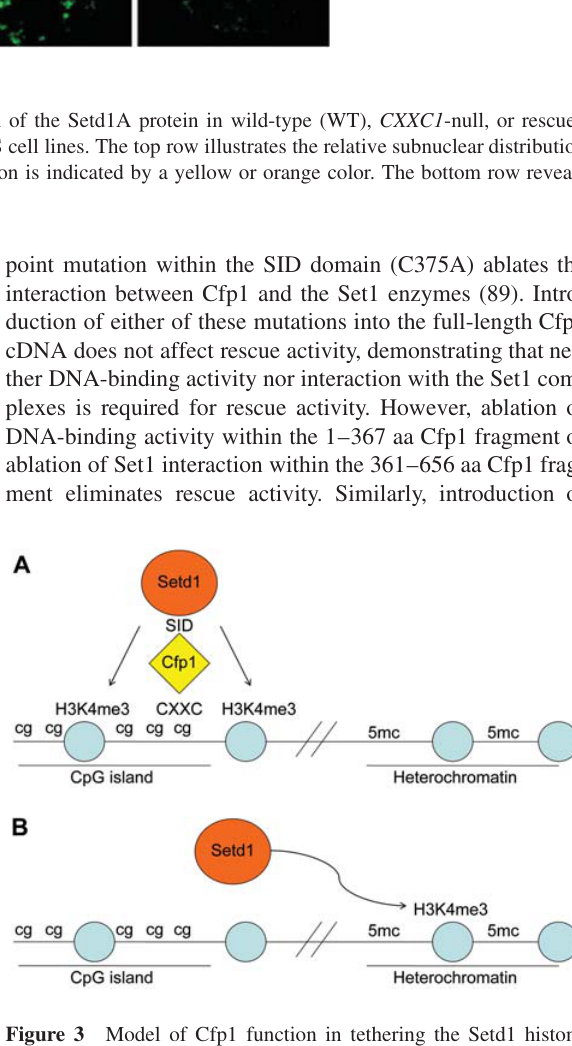
Figure 3 Model of Cfp1 function in tethering the Setd1 histone H3-Lys4 methyltransferase complexes to unmethylated